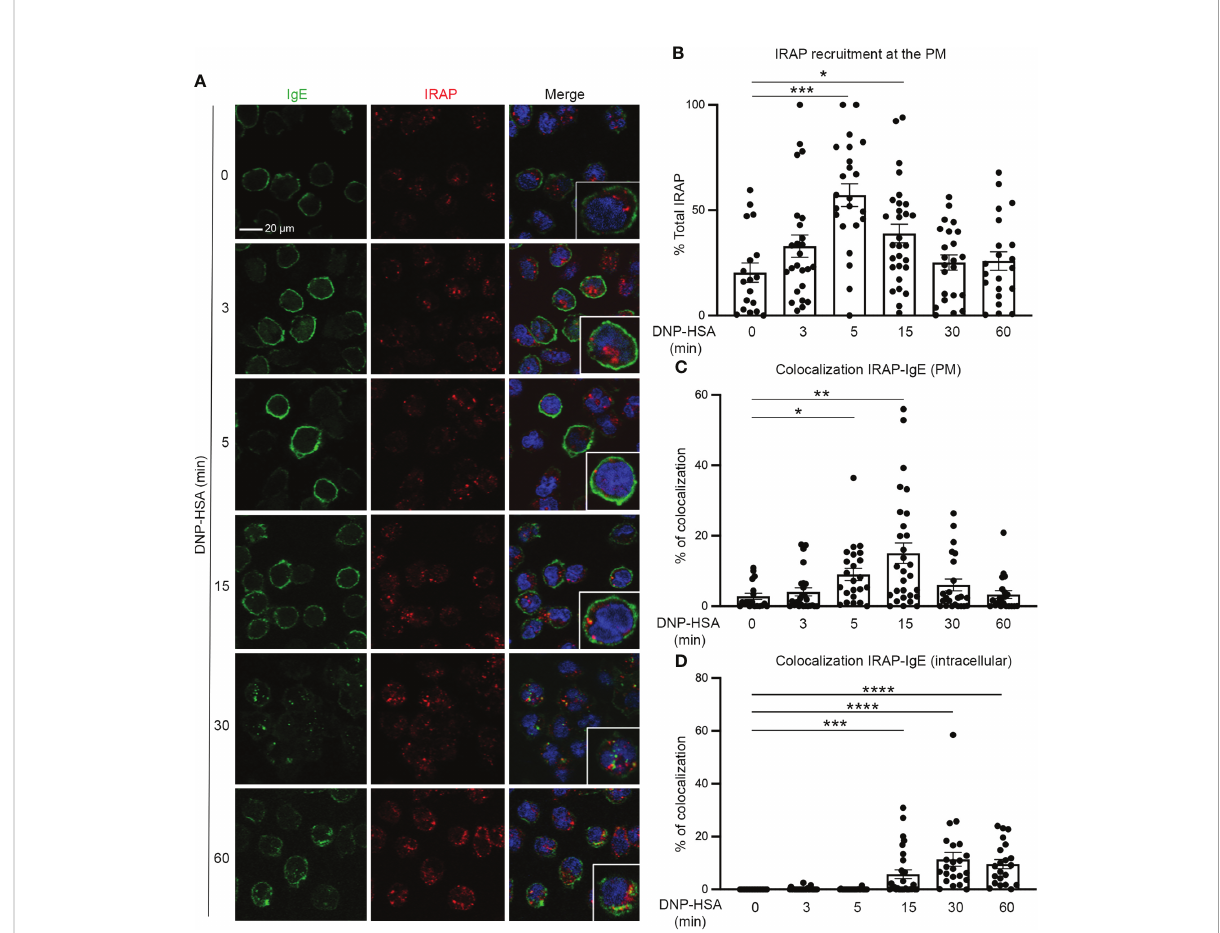
FIGURE 3 IRAP rapidly relocates to the plasma membrane and partly colocalizes with IgE after stimulation of mast cells with Ag. (A) WT BMMCs were sensitized with anti-DNP IgE and were then plated on fi bronectin-coated glass coverslips. Cells were stimulated for indicated time points with antigen DNP-HSA. After fi xation and permeabilization cells were stained with DAPI (blue), anti-IgE (green) and anti-IRAP (red) and analyzed by confocal microscopy. Images show representative sections with multiple cells for IgE and IRAP single staining as well as the merge of all colors. In the merge an insert with an enlarged cell is shown to evidence colocalization. (B) Quantitative analysis of plasma membrane recruitment was determined as described in Materials & Methods. (C) Quantitative analysis of colocalization of IRAP and IgE at the plasma membrane (PM) or (D) intracellularly following internalization of Fc e RI-bound IgE. Note that internalization of Fc e RI-bound IgE starts at 15 min. (B, C, D) Statistical analysis for plasma membrane recruitment and colocalization of IgE with IRAP was done using the one-way ANOVA followed by a Kruskal Willis post-test. Data shown are presented as the mean ± s.e.m of indicated individual cells (pooled from 3 experiments). *: P < 0.05; **: P < 0.01; ***: P < 0.001; ****: P <